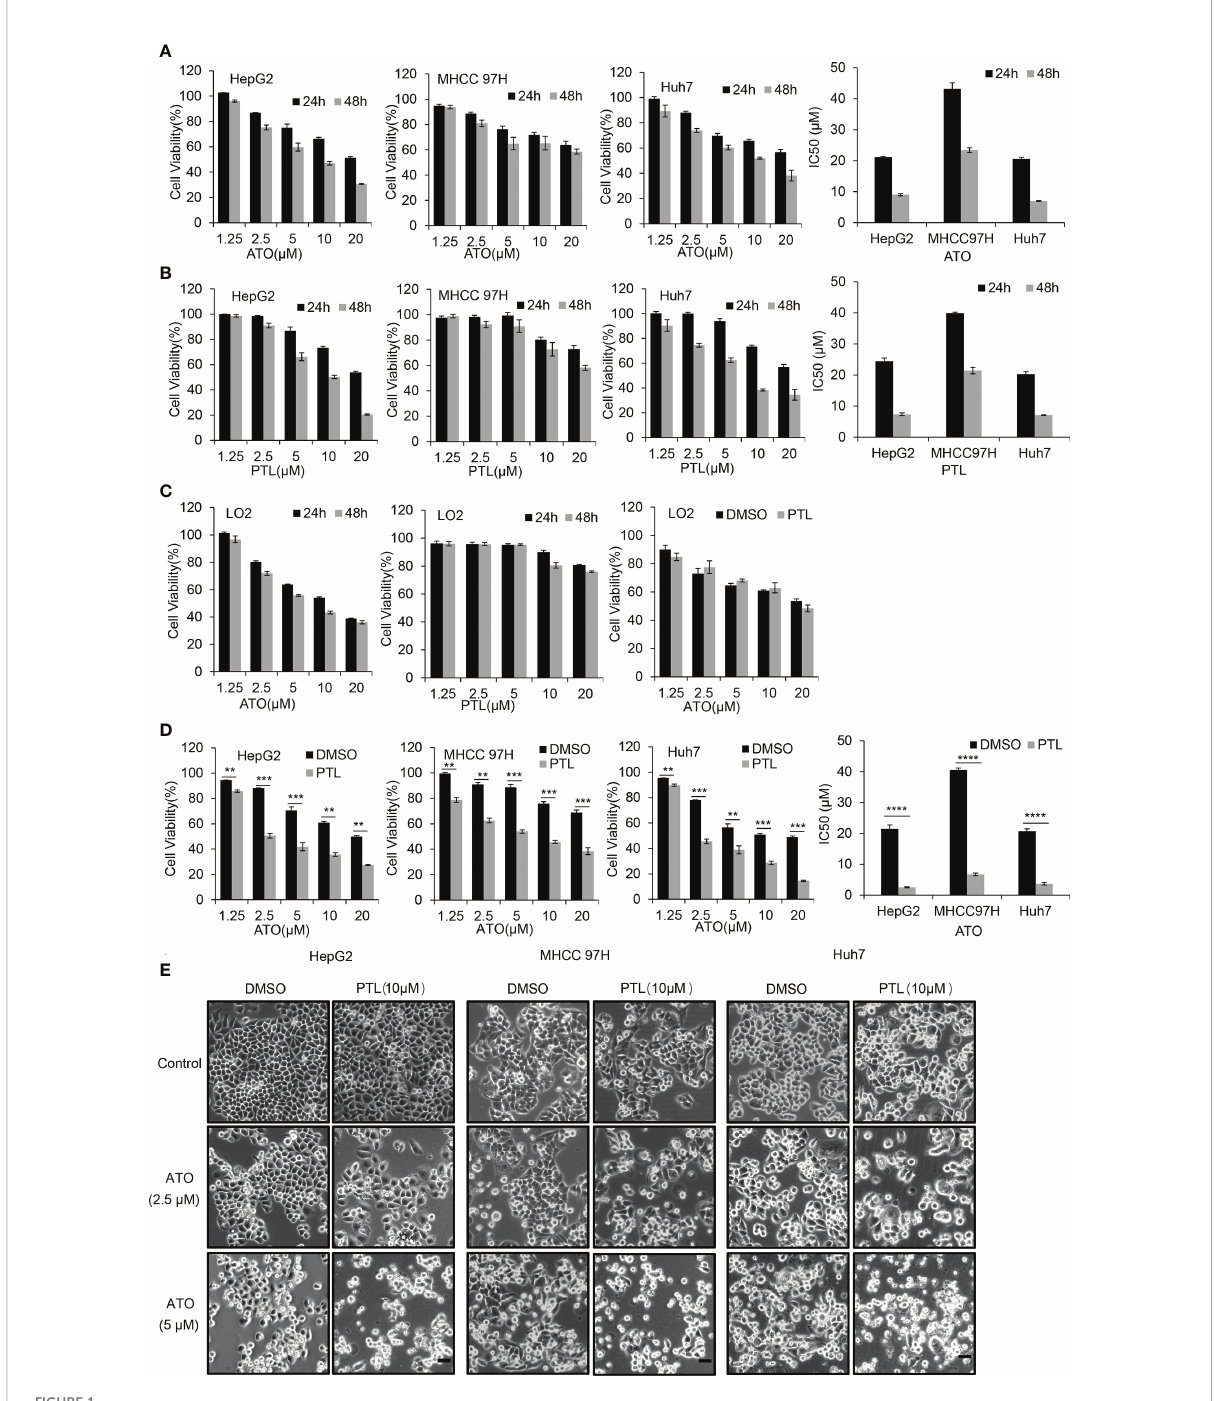
FIGURE 1 PTL enhances the effect of growth suppression of HCC cell lines mediated by ATO without in fl uence on the normal hepatocyte LO2 cells. (A, B) MTT assay showing the viability of HepG2 cells, MHCC97H cells and Huh7 cells after exposure to increasing concentrations of ATO or PTL for 24 h and 48 h. The half-maximal inhibitory concentration (IC50) of ATO or PTL was calculated ( P < 0.0001 vs. Control). (C) LO2 cells were treated different concentrations of ATO, PTL or ATO plus PTL for 24 h or 48 h, and the cell viability was measured by MTT assay. (D) After exposure to indicated concentrations of ATO, PTL and ATO plus PTL for 24 h, the cell viability was tested by MTT assay and IC50 was calculated (** P < 0.01; *** P < 0.001; **** P < 0.0001). (E) After exposure to indicated concentrations of ATO, PTL and ATO plus PTL for 24 h, the changes of cell morphology were observed under microscope. Scale bar: 20 m